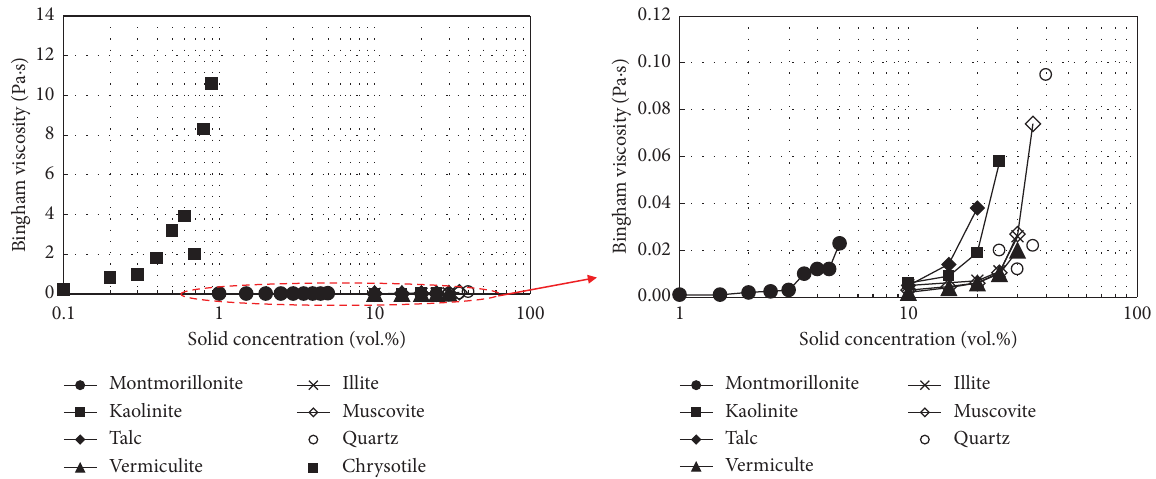
Figure 5: Comparison of the Bingham viscosities of different minerals (after